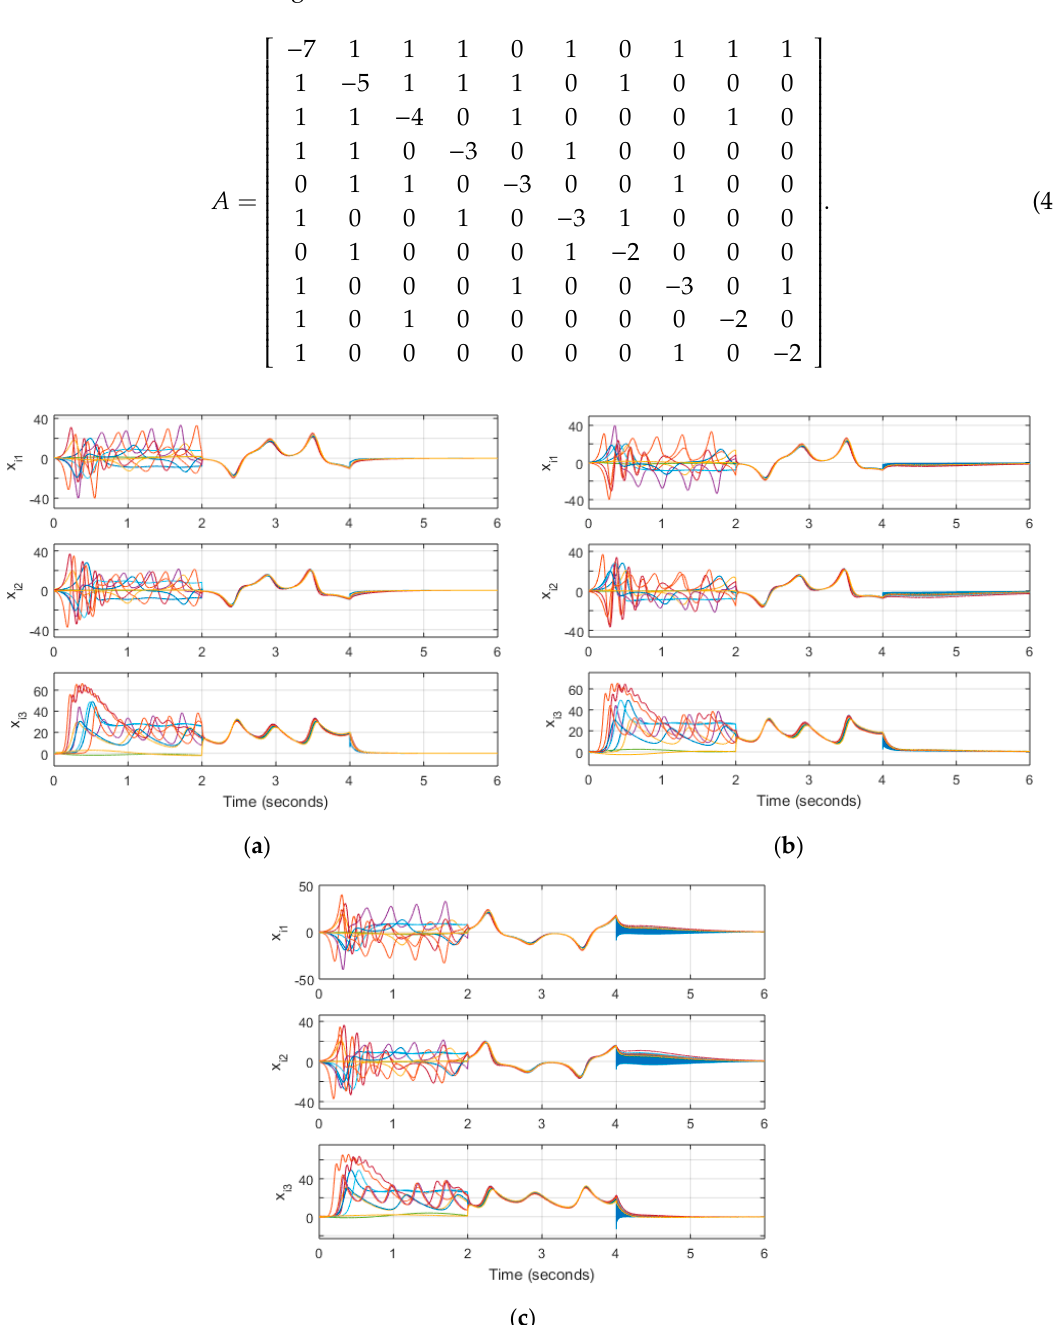
Figure 13. Complex network node dynamics of the ten node network when there is one controller, there is no noise in the system and: ( a ) Control input is applied at every time step with gain d 1 = − 400; ( b ) Control input is applied every 5T with gain d 1 = − 900; ( c ) Control input is applied every 10T with gain d 1 = −